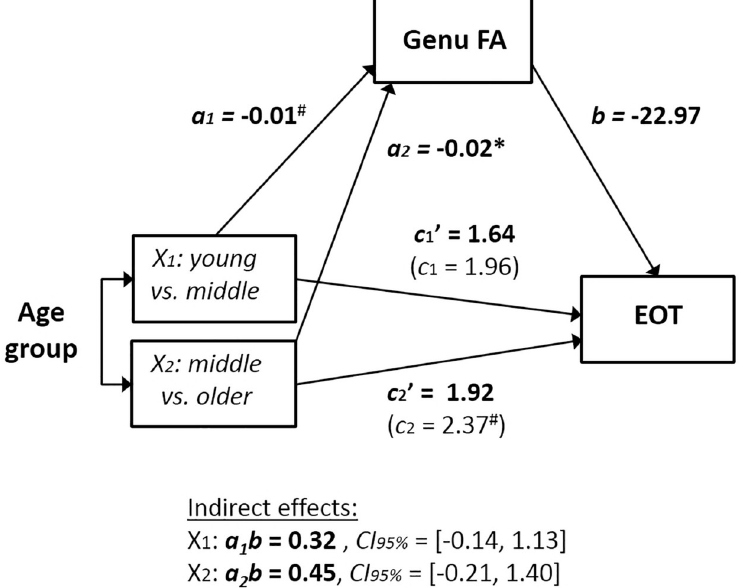
Fig 5. Mediation analysis. Estimated callosal mediation model for the prediction of EOT by age group and considering genu FA as mediator. Sequential coding was utilized for Age group, resulting in two predictors contrasting the young and the middle age group (X 1 ) and the middle age with the older age group (X 2 ), respectively. Parameter a represents the unstandardized regression weight for Age group prediction the mediator variable Genu FA, parameter b represents the regression weight for the mediator predicting the dependent variable EOT, and parameter c ’ represent the direct effect of Age group on EOT. Parameter c represents the prediction without considering Genu FA. The indirect effect estimates are noted as a and a , respectively. Subscript numbers 1 and 2 of the path regression 1 b 2 b weights (a, c, and c’) indicate on which of the two Age group predictors the estimation was based. Significant effects ( p < .05) are indicated by asterisk ( � ), and trends ( p < .10) by a number sign